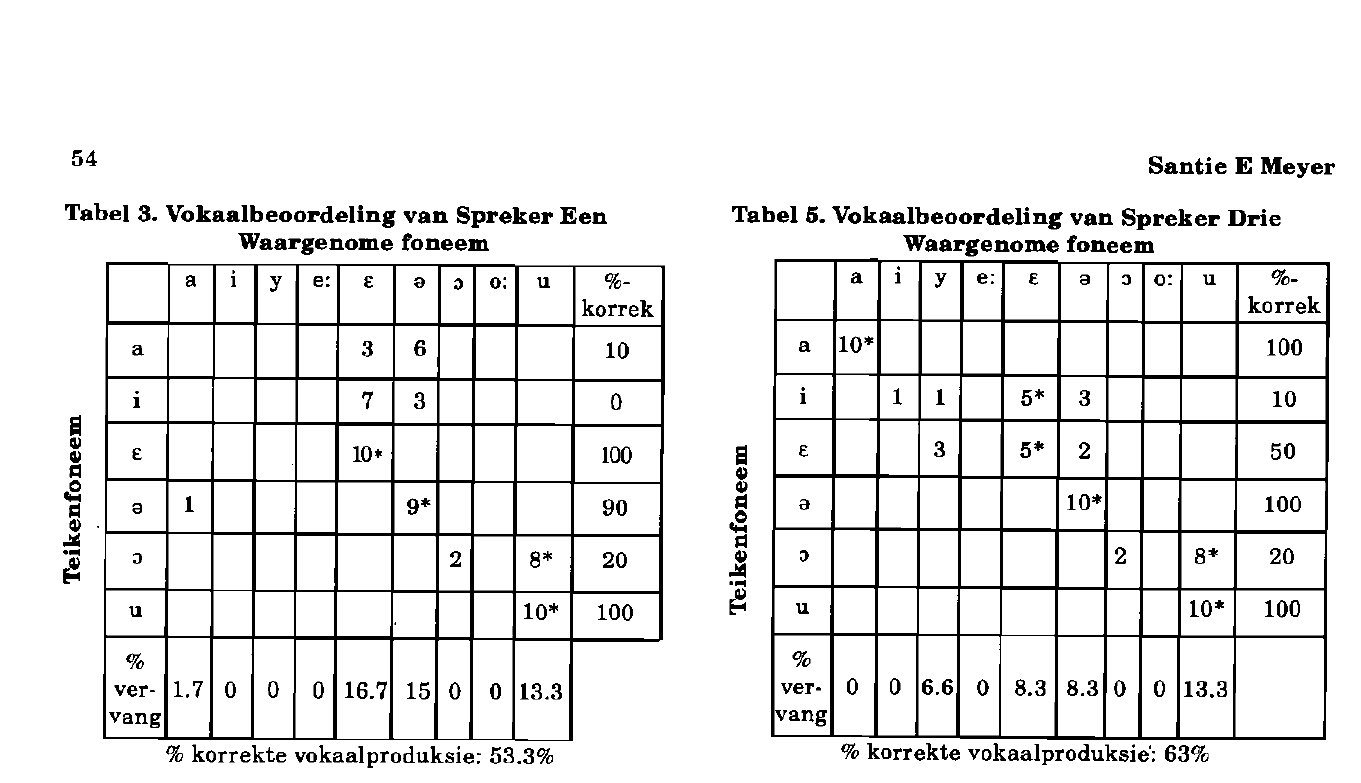
vokaalbeoordelings van Spreker Een